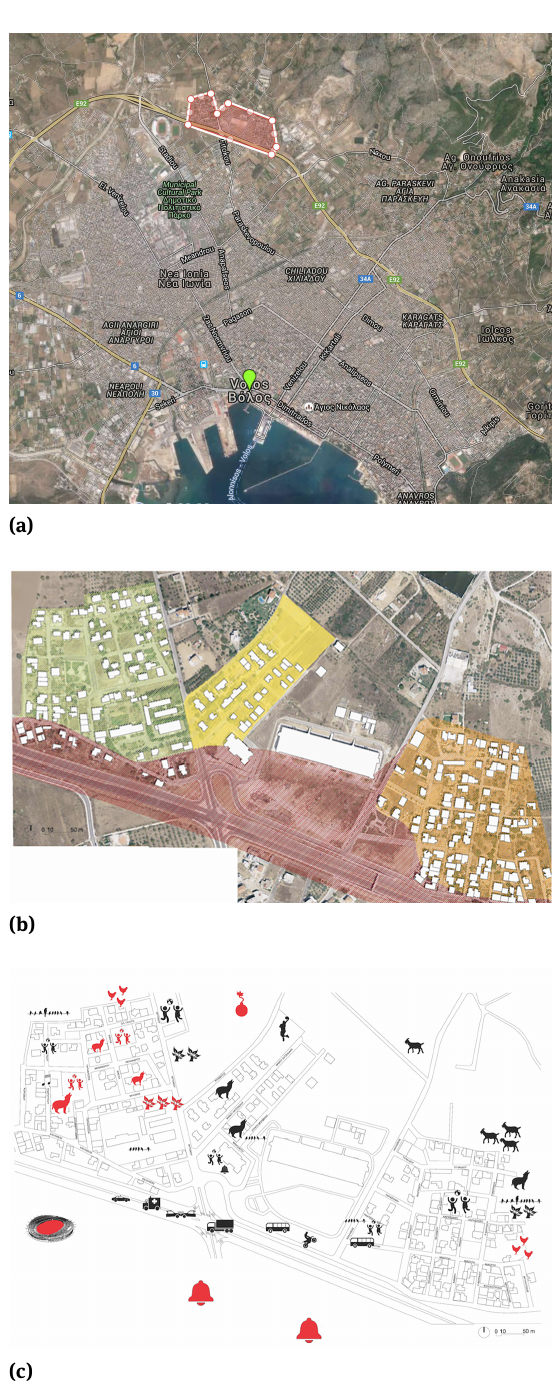
Figure 8: (a) Fitokou district localization in Volos U.A., (b) Visualiza- tion of the 4 sound identities of the district and (c), Sound signals (black color) and sound markers (red color) of the district,